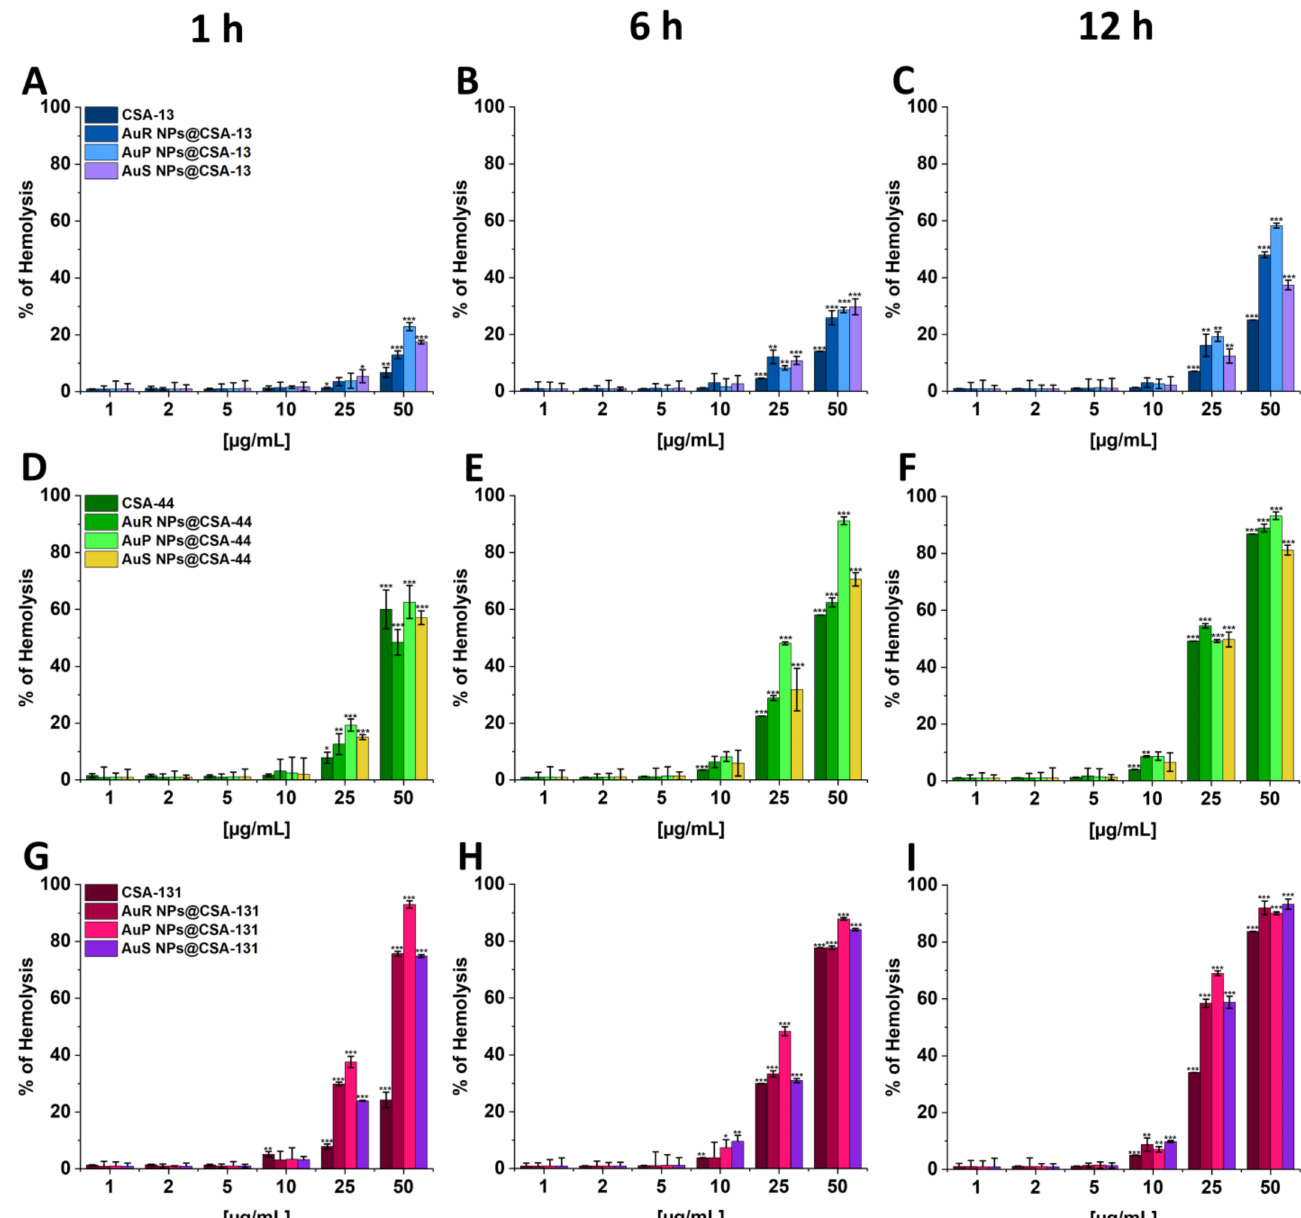
Figure 9. Hemoglobin release from human red blood cells (RBCs) incubated in the presence of CSA-13; AuR-NPs, AuP-NPs, and AuS-NPs containing CSA-13 ( A – C ); CSA-44; AuR-NPs, AuP-NPs, and AuS-NPs containing CSA-44 ( D – F ); and CSA-131; AuR-NPs, AuP-NPs, and AuS-NPs containing CSA-131 ( G – I ) at doses of 1–50 µ g/mL after 1 h ( A , D , G ), 6 h ( B , E , H ), and 12 h ( C , F , I ) of incubation. Results show the mean ± SD, n = 3; * indicates statistical significance at ≤ 0.05, ** ≤ 0.01, and *** ≤